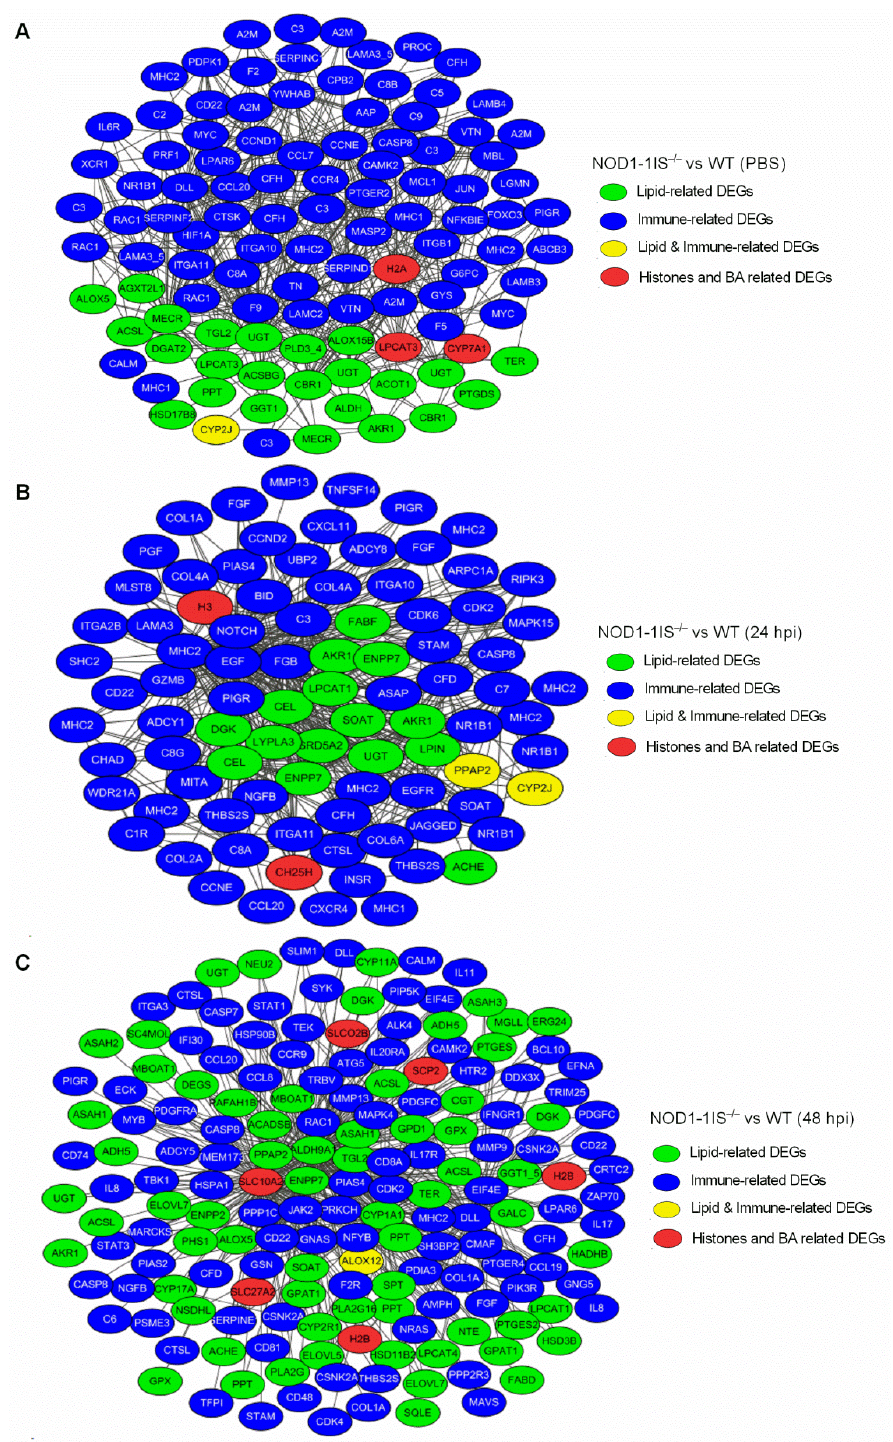
Figure 6. Co-occurrence network relationship among immune-related and metabolism-related DEGs via WGCNA analysis. ( A ) Co-occurrence network relationship among immune-related and metabolism-related DEGs in the NOD1-1IS − ⁄ − vs. WT groups injected with PBS. ( B ) Co-occurrence network relationship among immune-related and metabolism-related DEGs in NOD1-1IS − ⁄ − vs. WT group infected with S. agalactiae for 24 h. ( C ) Co-occurrence network relationship among immune- related and metabolism-related DEGs in the NOD1-1IS − ⁄ − vs. WT groups infected with S. agalactiae for 48 h. The node color indicates the biological function of each